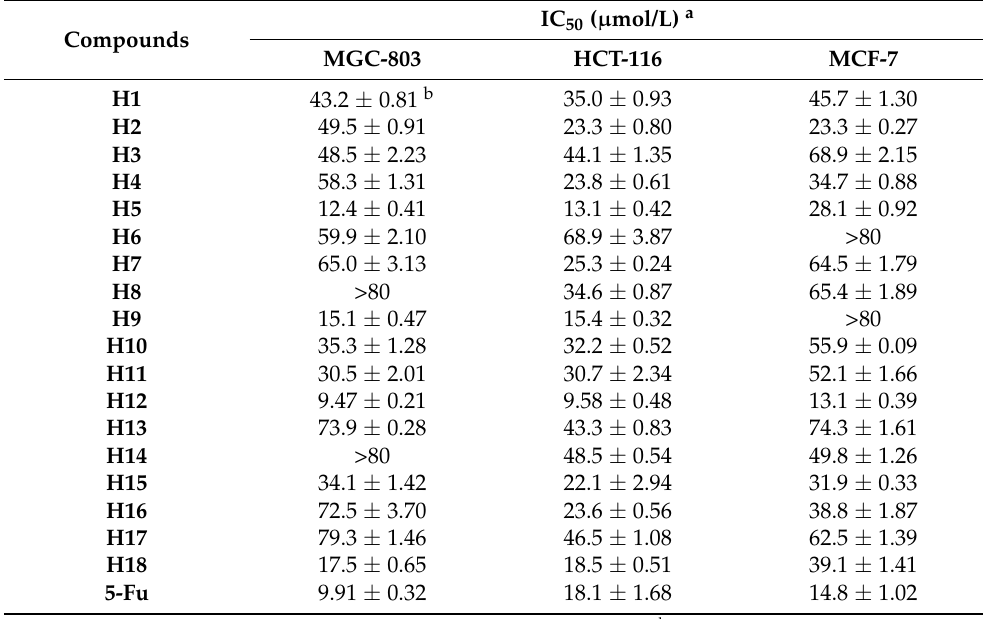
Table 1. In vitro antiproliferative activities of compounds H1 – H18 against three human cancer cells.